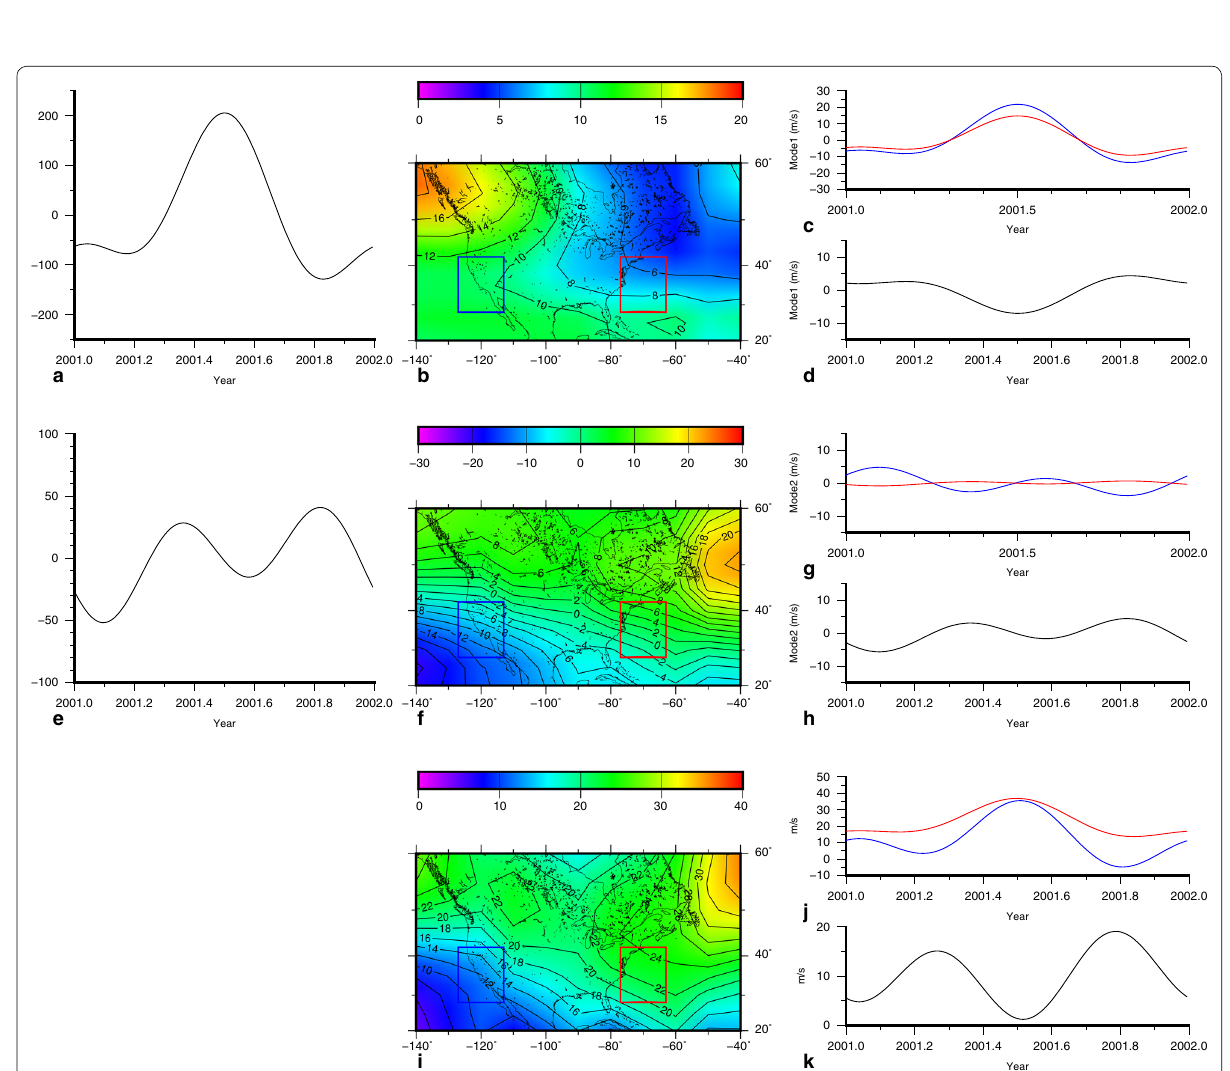
Fig. 7 V HWM07 over the North American region: a amplitude of the temporal variation, a 1 (the y -axis has to be multiplied by a factor of 10 − 2 ), b eigenvector or spatial variation, e 1 , c synthesized data for mode 1 ( a 1 e 1T ) for red (east) and blue (west) rectangles, d difference between red and blue · curves of c , e the amplitude of the temporal variation, a 2 (the y -axis has to be multiplied by a factor of 10 − 2 ), f eigenvector or spatial variation, e 2 , e 2T ) for red (east) and blue (west) rectangles, h difference between red and blue curves of g . Finally, the time- g synthesized data for mode 2 ( a 2 · averaged ¯ V HWM07 ( x ) ( i ), the synthesized data, j ¯ V ∗ HWM07 ( t ) , for red (east) and blue (west) rectangles, and the difference ( d V ∗ HWM07 ( t ) ) between red and blue curves of j ( k